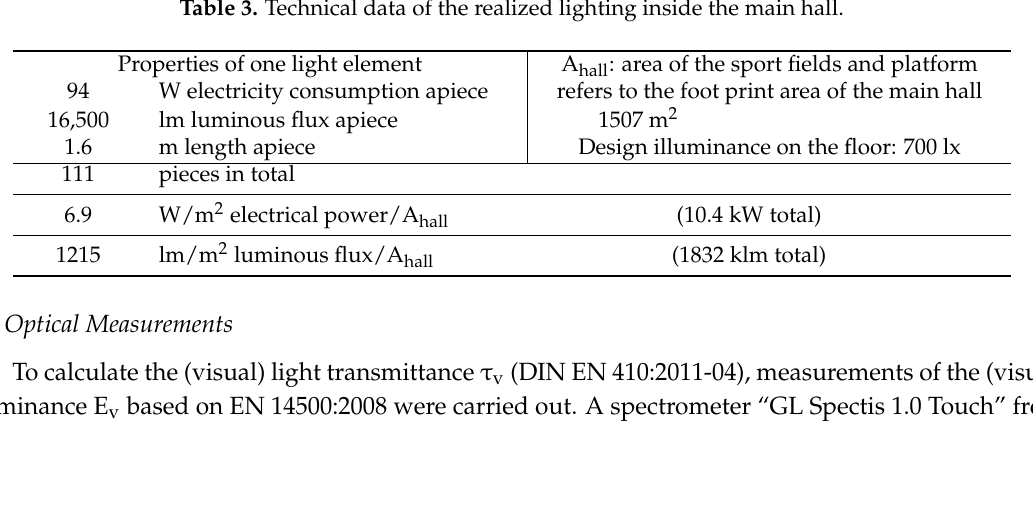
Table 3. Technical data of the realized lighting inside the main